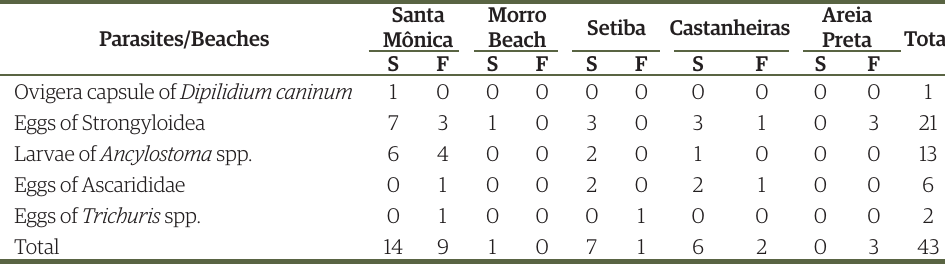
Eggs of Trichuris spp.